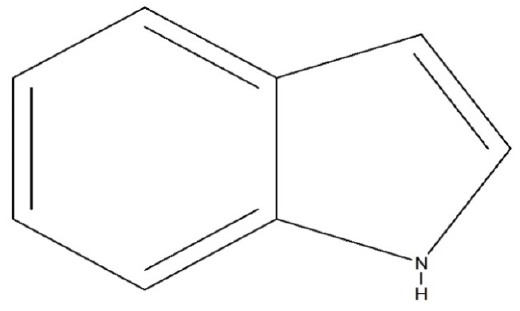
Figure 1. Chemical structure of indole.